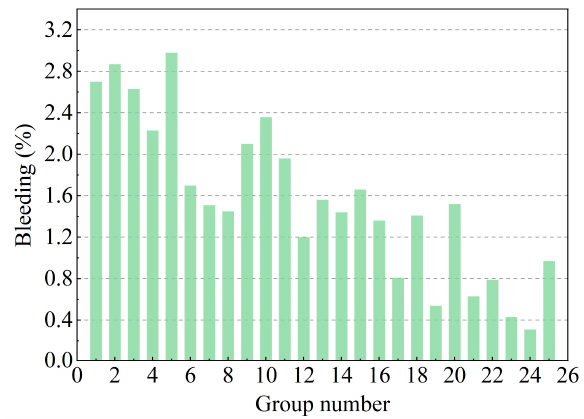
Figure 7. Test results of bleeding rate.